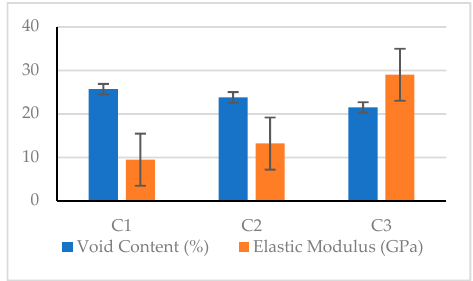
Figure 10. Relationship between elastic modulus and void content.